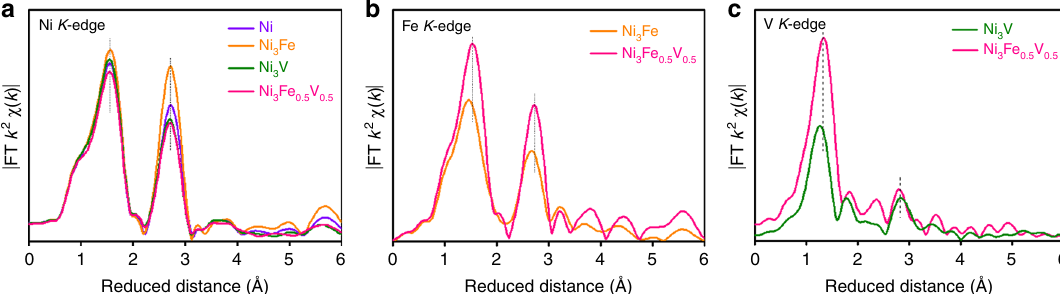
Fig. 3 XAS spectra of the as-prepared Ni-based (oxy)hydroxide catalysts. FT curves of a Ni K -edge, b Fe K -edge, and c V K -edge EXAFS k 2 χ ( k )